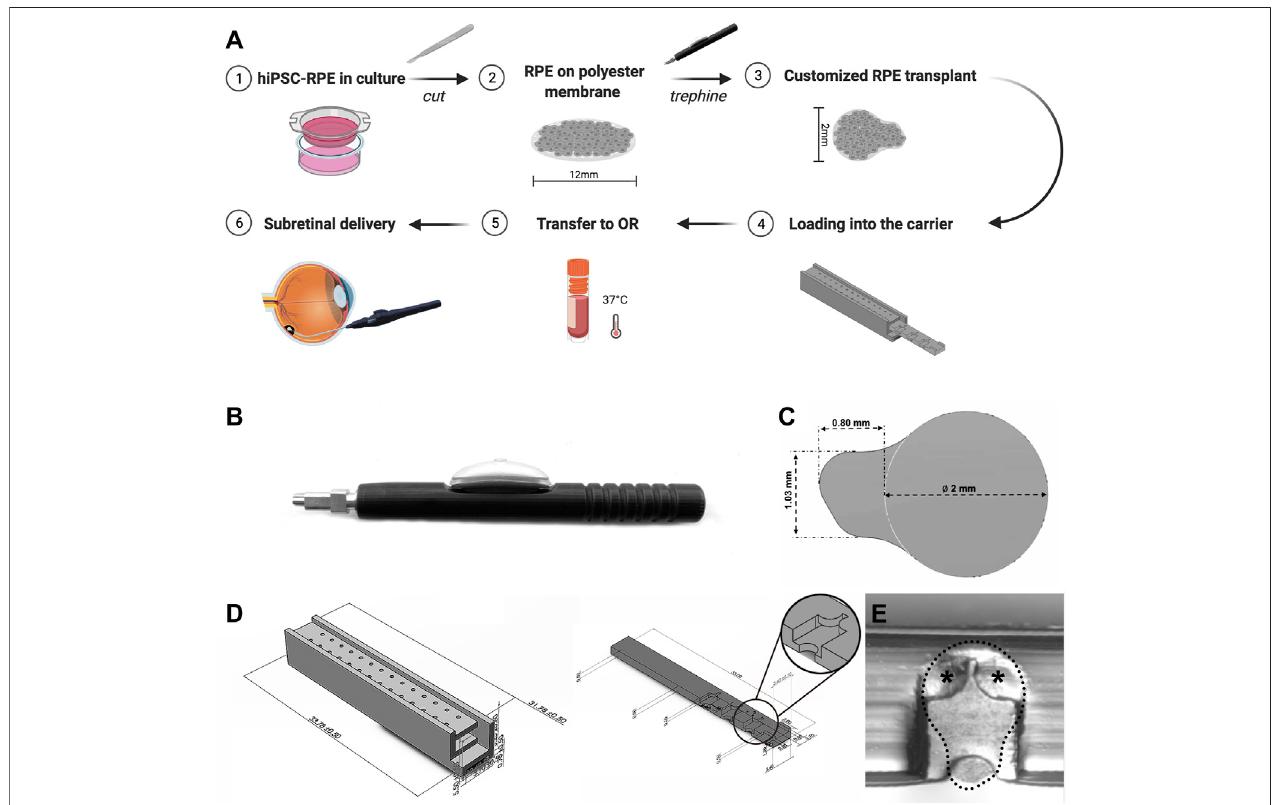
FIGURE 2 | Custom-designed trephine and carrier for production and preservation of hiPSC-RPE transplants. (A) Brief work fl ow outlining production, preservation, transportation, and sub-retinal delivery of hiPSC-RPE transplants and the custom-designed devices developed for each step. (B) Custom-designed trephine for hiPSC-RPE transplant production. (C) Shape and size of the hiPSC-RPE transplants produced with the trephine. (D) The transplant carrier includes a chest (left), and a drawer (right); the drawer contains chambers for docking the hiPSC-RPE transplants, and by sliding into the chest, the drawer protects the transplants from movingordamage. (E) AhiPSC-RPE transplant positionedinsideachamber ofthedrawer (dotted line);twosmallsymmetrical fl atpieces atthetopofthechamber (asterisks) prevent the hiPSC-RPE transplants from fl oating away from the chamber.